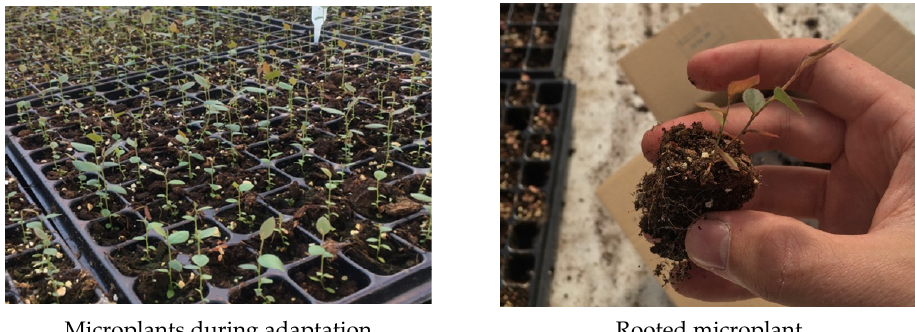
Figure 1. Rooting process of highbush blueberry ( Vaccinium corymbosum L.) cv. Brigitta Blue.